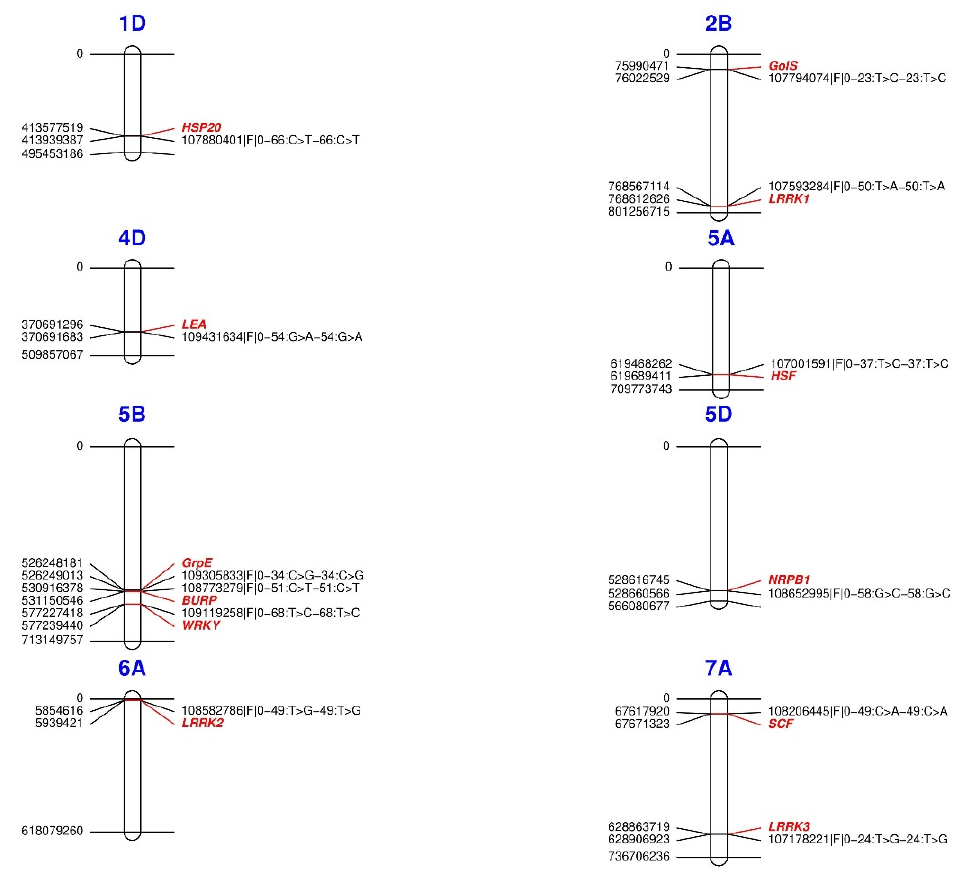
Figure 6. Physical map of the location of SNPs associated with heat and drought tolerance-related genes in Triticum aestivum . For each locus, the position is written on the left side, whereas SNPs are coded on the right side. Gene names are colored. HSP20 = Heat shock protein class VI; GolS = Galactinol synthase 7; LEA = Late embryogenesis abundant ; HSF = Heat shock factor ; GrpE = GrpE protein homolog; BURP = BURP domain; WRKY = Probable WRKY TF 57; NRPB1 = DNA-directed RNA polymerase sub- unit; SCF = F-box component of the SKP-Cullin-F-box E3 ; LRRK = Leucine-rich repeat receptor-like kinase .